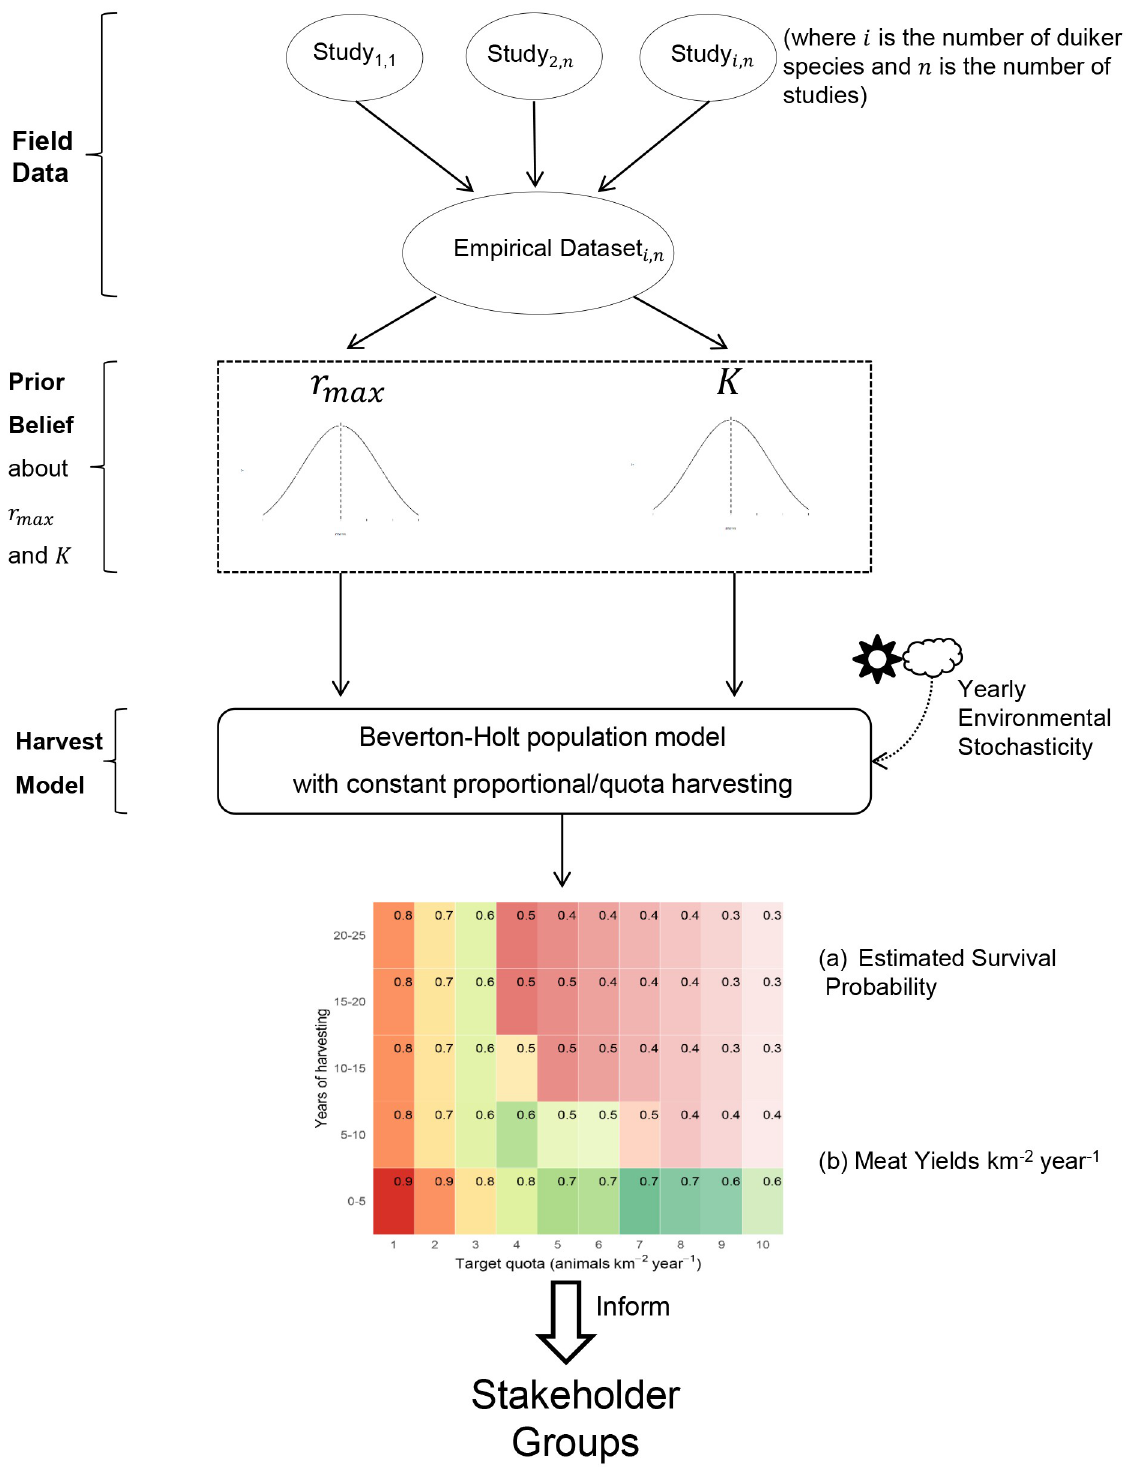
Fig 1. Our method of combining field data with the harvest model.